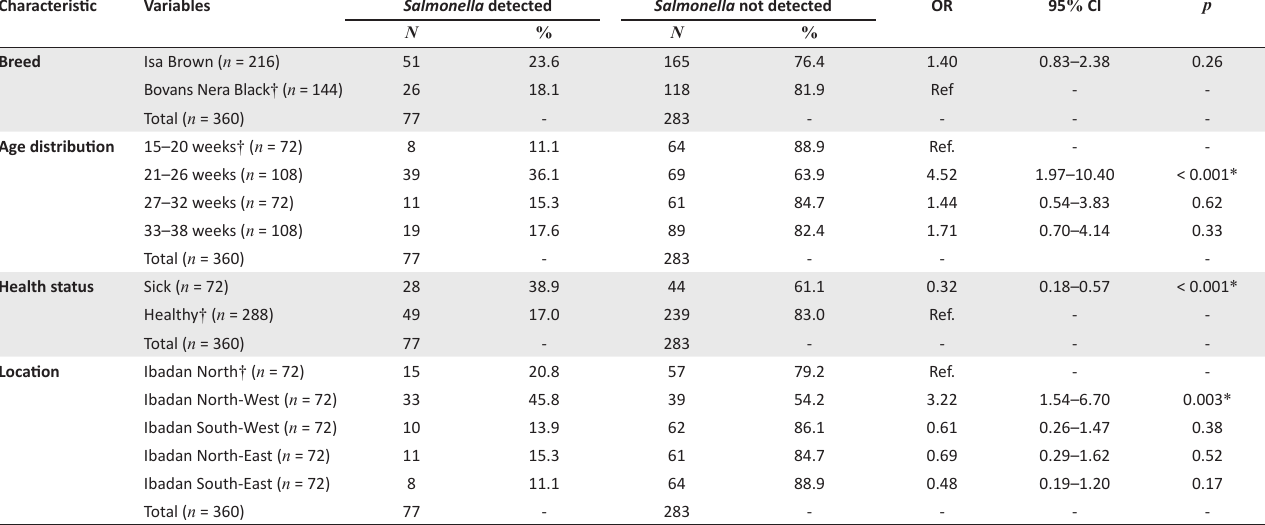
TABLE 1: Association between Salmonella prevalence and demographic variables of chickens from poultry farms in Ibadan metropolis, Nigeria, April 2018 – November 2018. Characteristic Variables